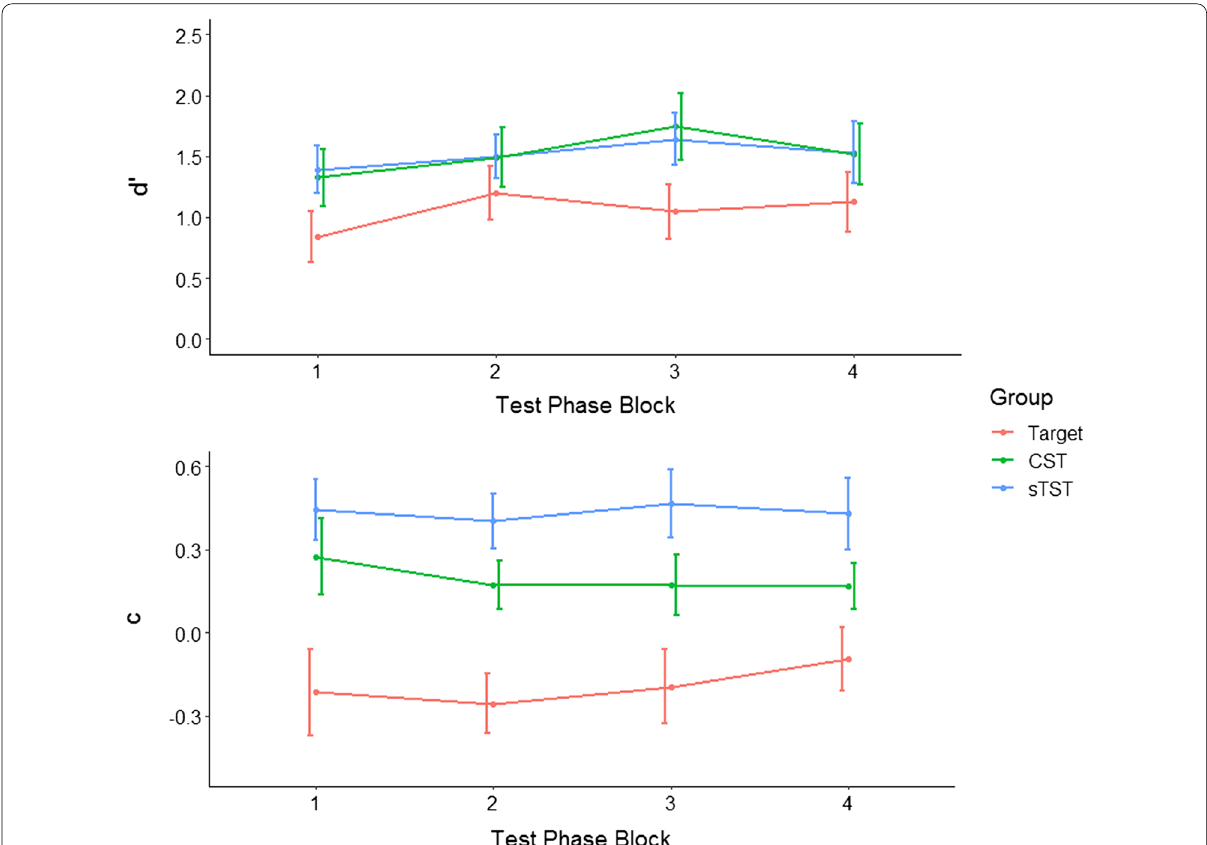
Fig. 5 Sensitivity ( d ′ ) and criterion ( c ) by test phase block (the test phase split into four equal blocks of 42 trials to indicate change over time) and training group for Experiment 1, error bars show 95% CIs)